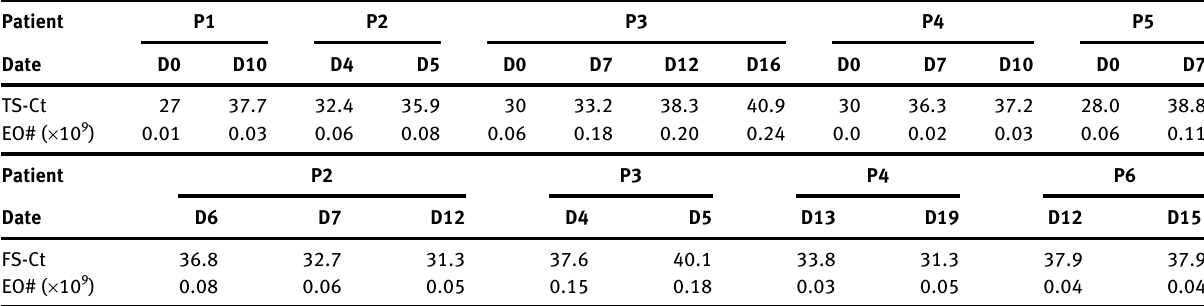
Table  : Ct values of nucleic acid in throat swabs and feces and EO#.